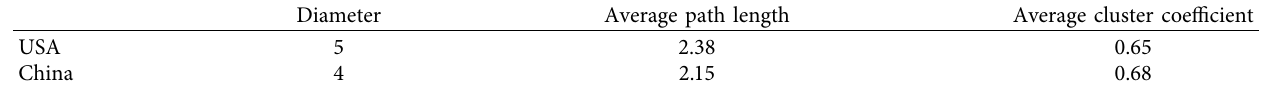
Table 3: Basic network properties of the US and China